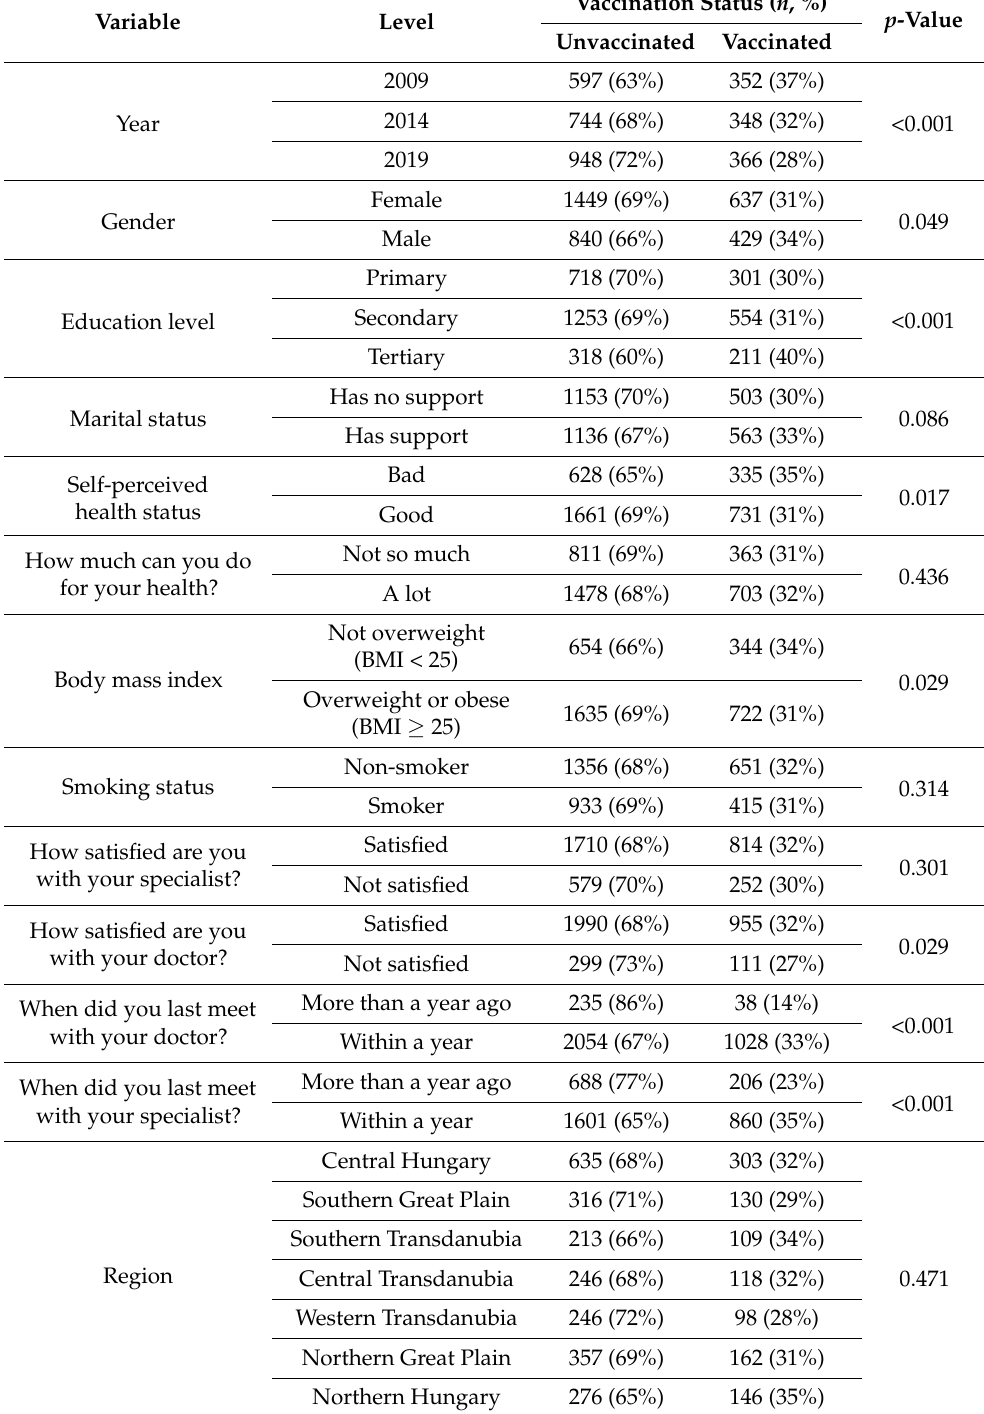
Table 1. Descriptive statistics by vaccination status of survey respondents aged 65 or